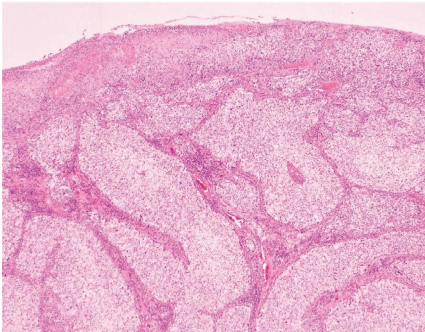
Figure 1: SC at low power (4x magnifcation) shows a large multinodular tumor invading the dermis with difuse overlying ulceration present.